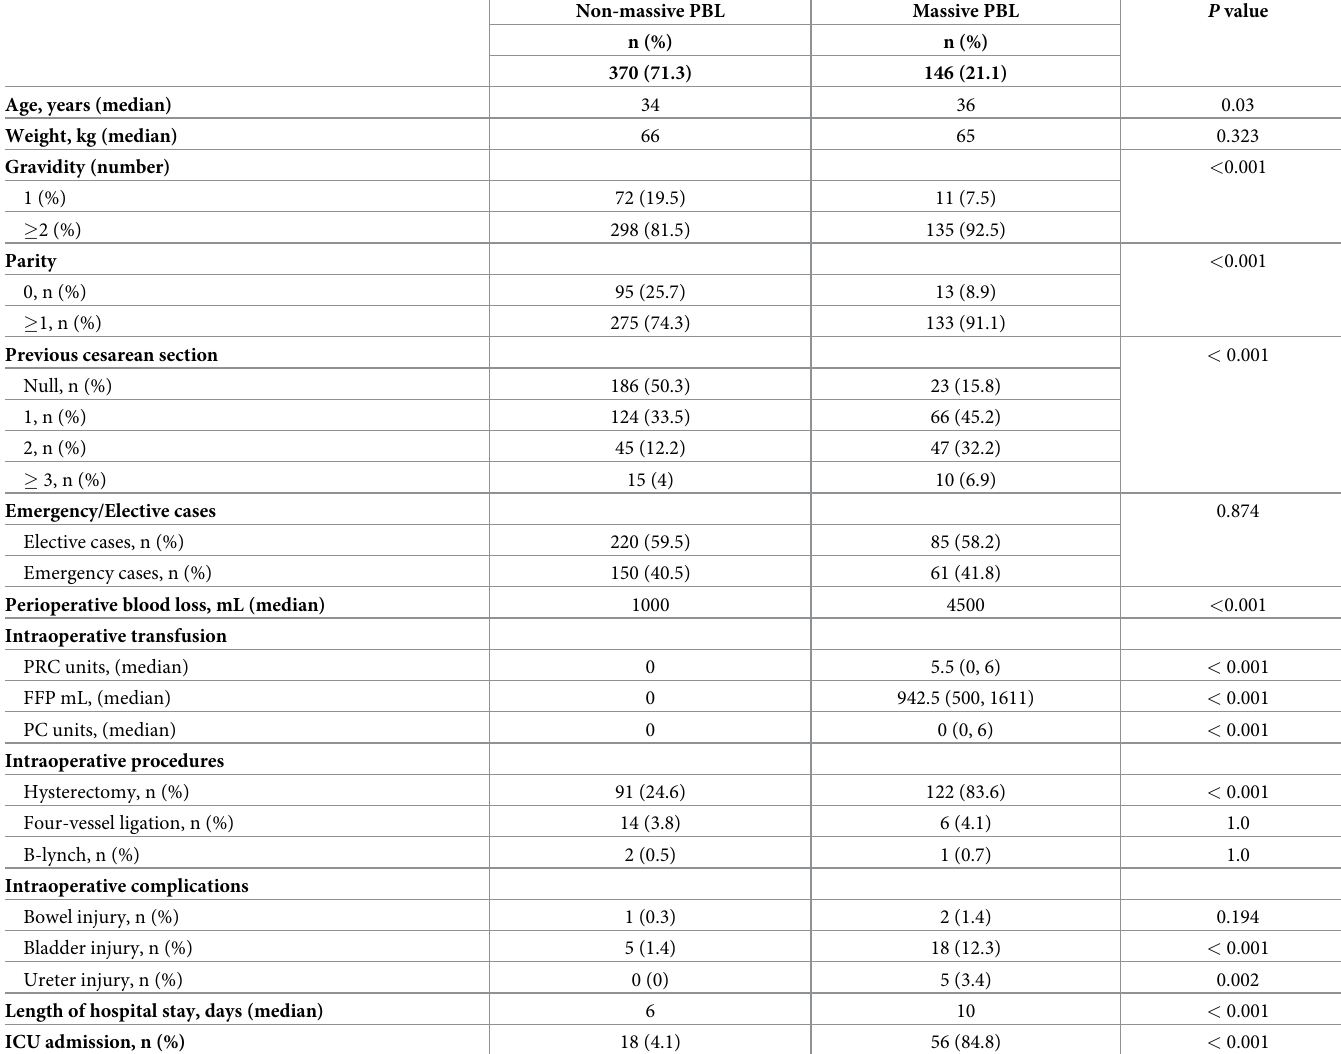
Table 1. Patient characteristics compared between the non-massive and massive perioperative blood loss (PBL)